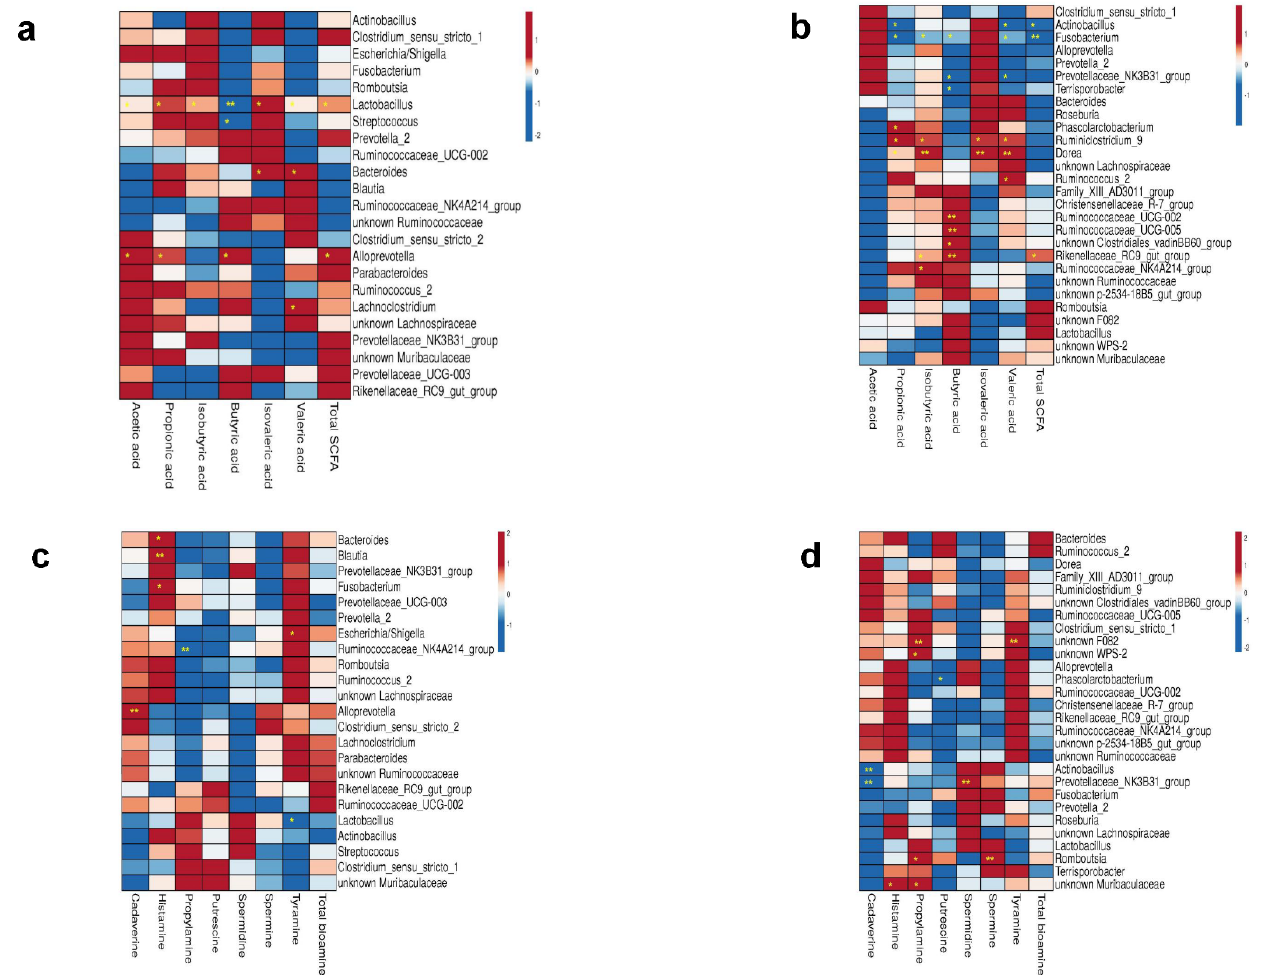
Figure 3. Concentration of bacterial metabolites and their correlation with bacteria having an abun- dance > 0.5%. The data are presented as mean values, n = 5 for SCFAs between groups; n = 2 for biogenic amines at 5 d of age and n = 4 at 12 d of age; the colours range from blue (negative correlation) to red (positive correlation). Significant correlations are marked by ** p < 0.01 and * p < 0.05; ( a ) Spearman’s correlation between colonic microbiota with a general abundance > 0.5% and SCFAs at day 5; ( b ) Spearman´s correlation between colonic microbiota with a general abundance > 0.5% and SCFAs at day 12; ( c ) Spearman´s correlation between colonic microbiota with a general abundance > 0.5% and biogenic amines at day 5; ( d ) Spearman´s correlation between colonic microbiota with a general abundance > 0.5% and biogenic amines at day 12. The colours range from blue (negative correlation) to red (positive correlation). Significant correlations are marked by ** p < 0.01 and * p < 0.05.